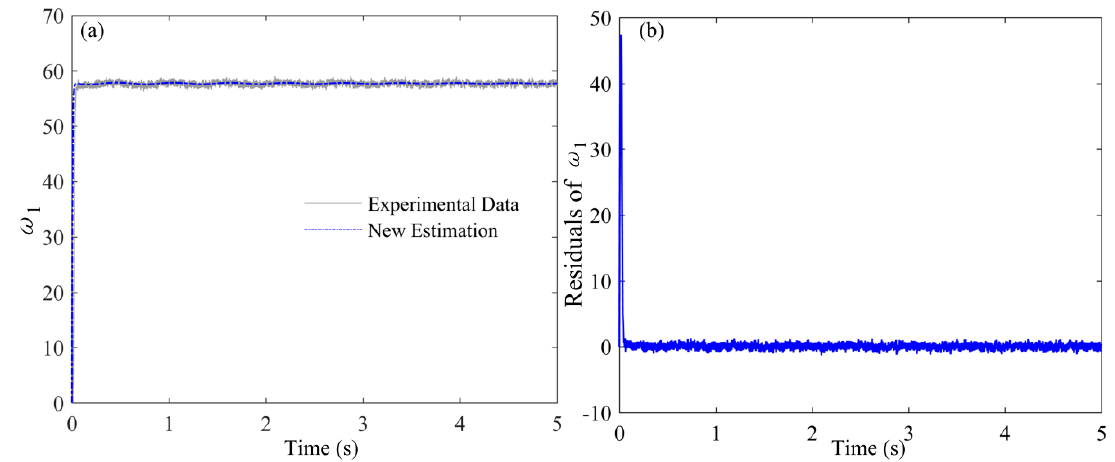
Figure 4. Tracking effect and identification error of the simulation model on the angular velocity of joint I: ( a ) tracking effect; ( b ) tracking error.